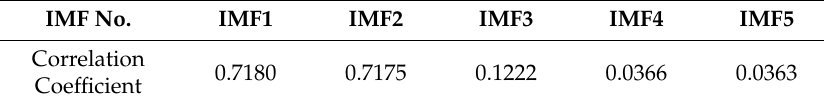
Table 2. Correlation coefficients of IMFs of the simulated chatter signal.